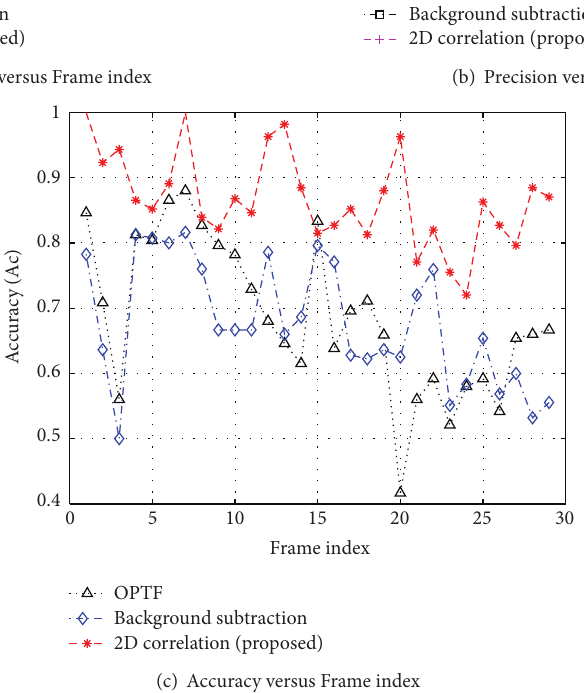
Figure 7: Comparative analysis of frame based surveillance metrics on “FaceOcc2” data